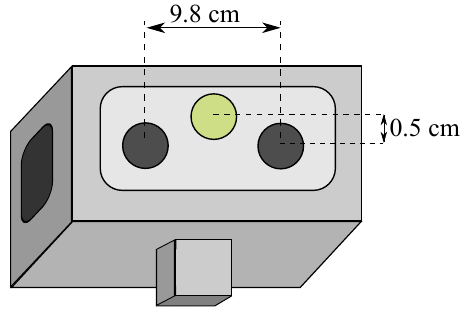
Figure 9. Scheme for Stereo and Thermal Cameras